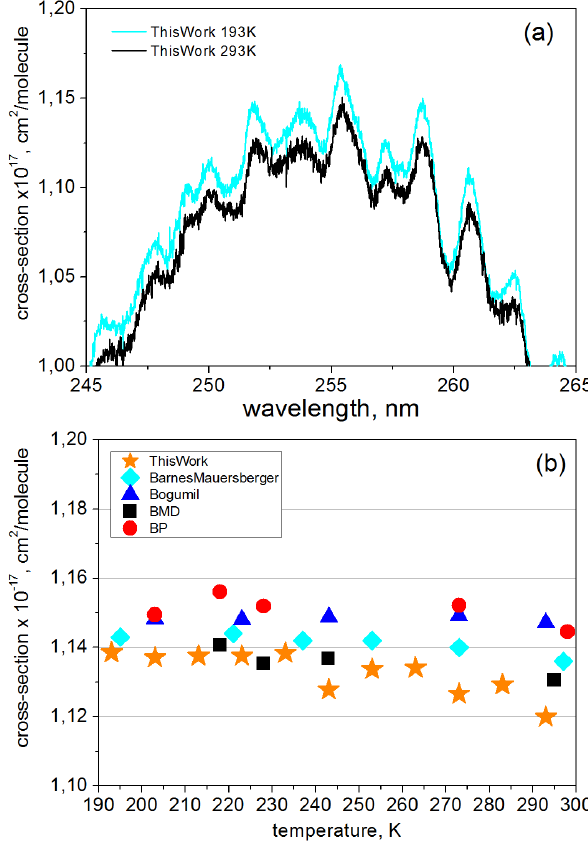
Fig. 3. Temperature dependence of the new experimental cross- sections in the UV region: (a) cross-sections for 293K (dark line) and 193K (light line); (b) temperature dependence at 253.65nm. Stars – new experimental data; diamonds – Barnes and Mauers- berger (1987); triangles – Bogumil et al. (2003); squares – BMD; circles –